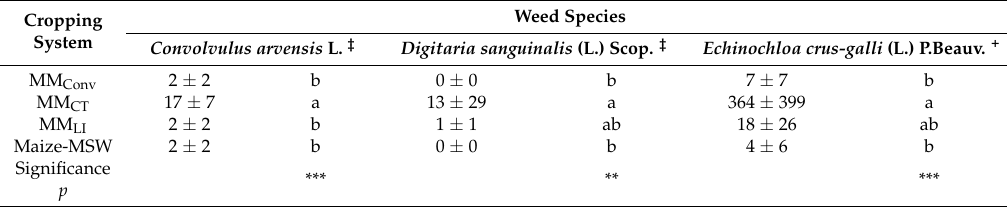
Table 1. Weed species’ potential of infestation (mean ± standard deviation, no. of plants m − 2 ) of the four cropping systems (MM Conv : conventional maize monoculture; MM CT : conservation tillage maize monoculture; MM LI : low-input maize monoculture; Maize-MSW: integrated maize rotation). For each weed species, mean values sharing the same letter (“a” and/or “b”) are not different according to Tukey’s HSD test (denoted with + ) or Kruskal-Wallis test (denoted with ‡ ) (** p < 0.01, *** p < 0.001). Weed Species Cropping System Convolvulus arvensis L. ‡ Digitaria sanguinalis (L.) Scop. ‡ Echinochloa crus-galli (L.) P.Beauv. + MM Conv 2 ± 2